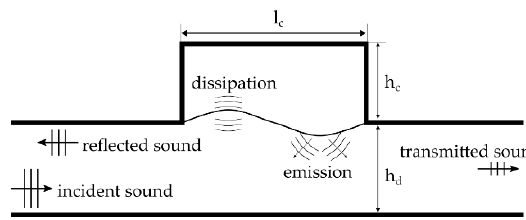
Figure 7. Sketch of a simple plate silencer.